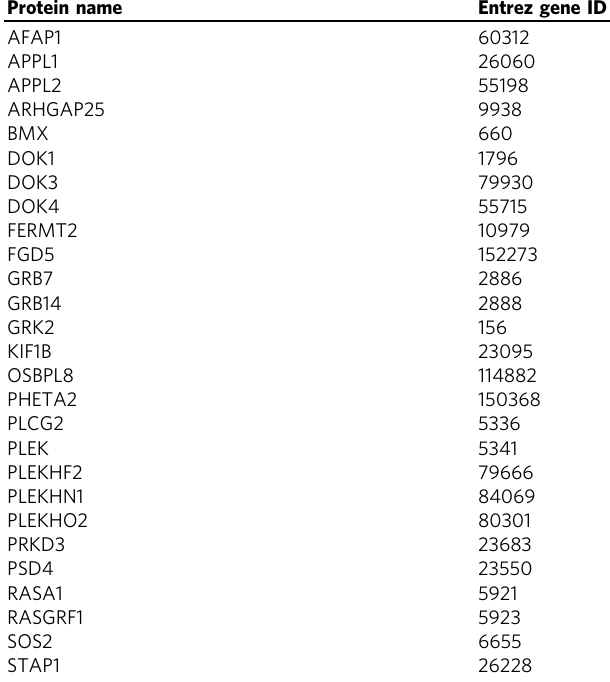
Table 1 Lipid-SiMPull assay results for 40 PIP-binding PH domain-containing proteins.